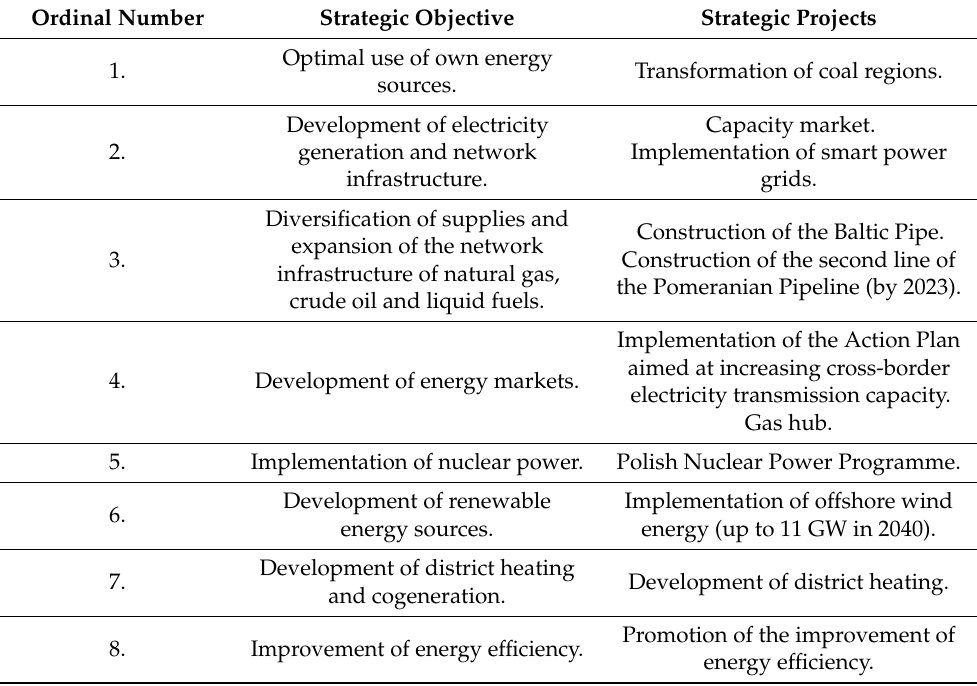
Table 1. EPP2040s specific objectives and associated strategic